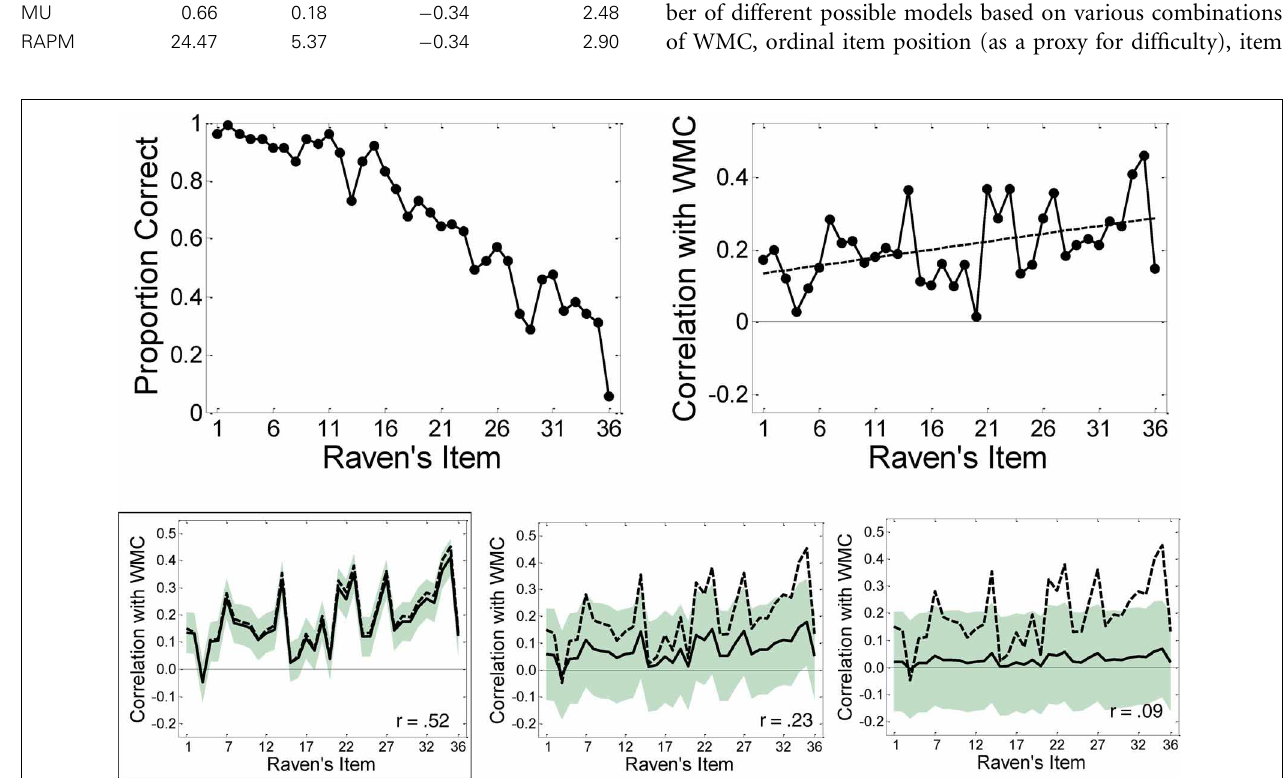
FIGURE 5 | Top left: Performance on Raven’s advanced progressive matrices items. Top right: Observed correlations between working memory capacity ( z WMC; based on a battery of four tasks) and performance on each Raven’s item. The solid line represents the best-fitting regression line (intercept 0.13, slope 0.005). Bottom panels: Results from a bootstrapping analysis resulting